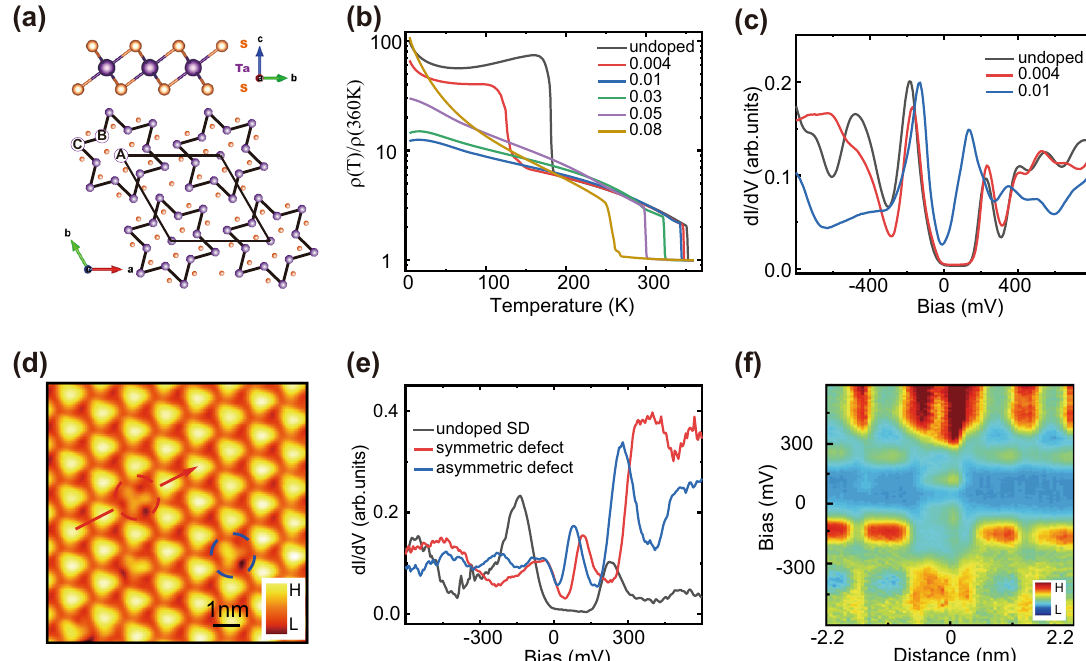
Fig. 1 Crystal structure and electronic state of 1 T -(Ta 1 − x Ti x )S 2 . a Side- and top-view sketches present the crystal structure of single-layer 1 T - TaS 2 . Top-view sketch especially shows the cluster of SD and the ( T )/ ρ (360K) for samples with different doping levels. c Typical dI / dV spectra of undoped, x = 0.004, and x = 0.01 samples. d A 9 × 9 nm 2 topography for the x = 0.004 sample ( V b = − 600 mV, I s = 500 pA). Red and blue circles mark a symmetric and an asymmetric Ti-doped SD, respectively. e The dI / dV spectra measured at the center of an undoped SD, a symmetric, and an asymmetric Ti-doped SDs, respectively. f A series of dI / dV spectra across the symmetric Ti-doped SD, along the red curve labeled in d